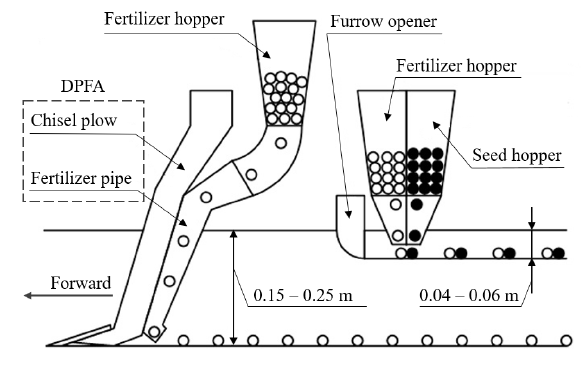
Figure 1: The mechanism of DPFA with simultaneous soybean sow- ing